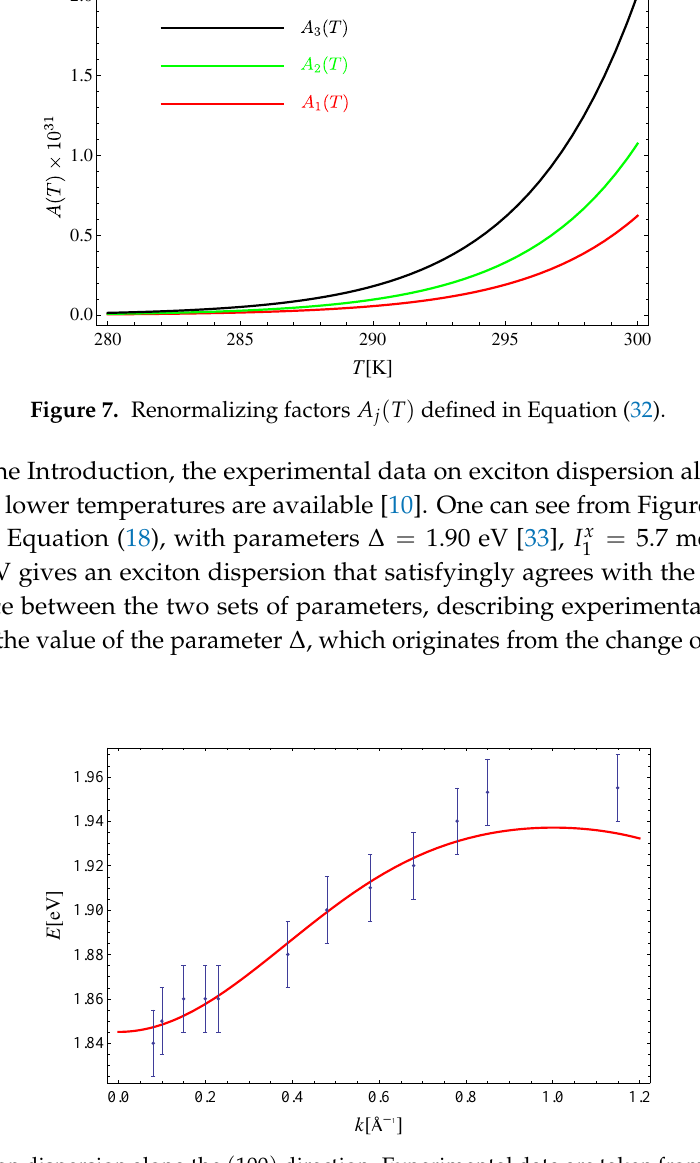
= 5.7 meV, I x = 3.4 meV and I x = 23.4 2 3 1